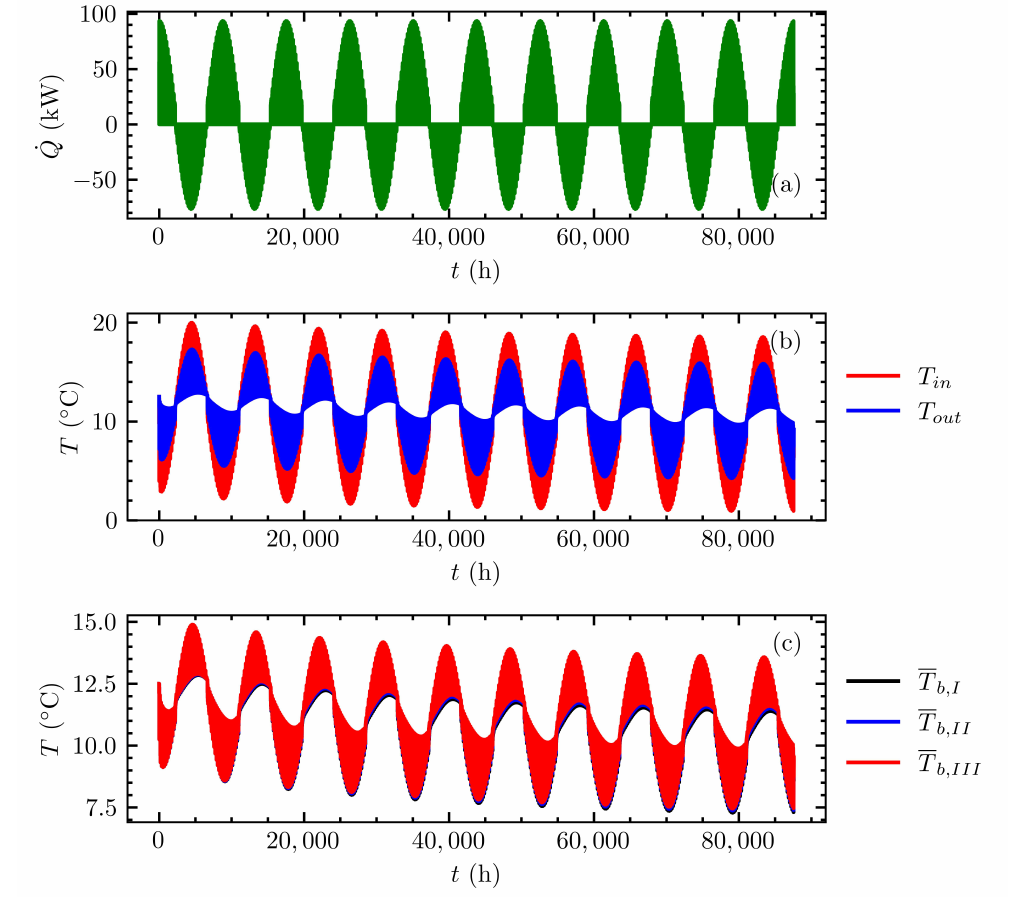
Figure 9. Multi-annual simulation over 10 years with the proposed method: ( a ) ground loads, ( b ) inlet and outlet fluid temperatures and ( c ) average borehole wall temperature at each equivalent